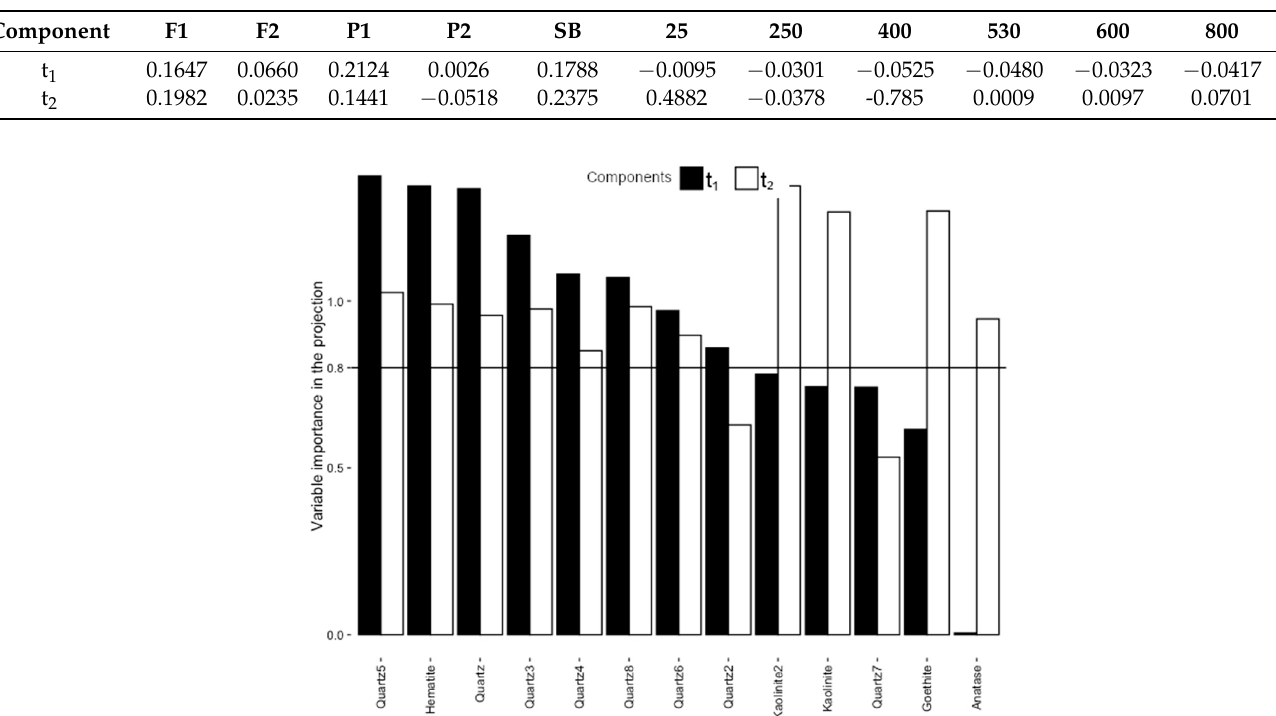
Figure 5. Graph of variable importance in the projection for components t 1 and t 2 . All variables lower than 0.8 importance were removed from the model.